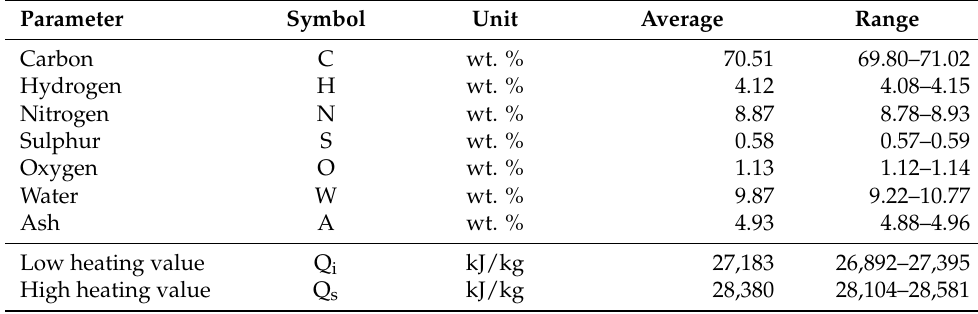
Table 2. Coal properties for the fluidized bed gasification